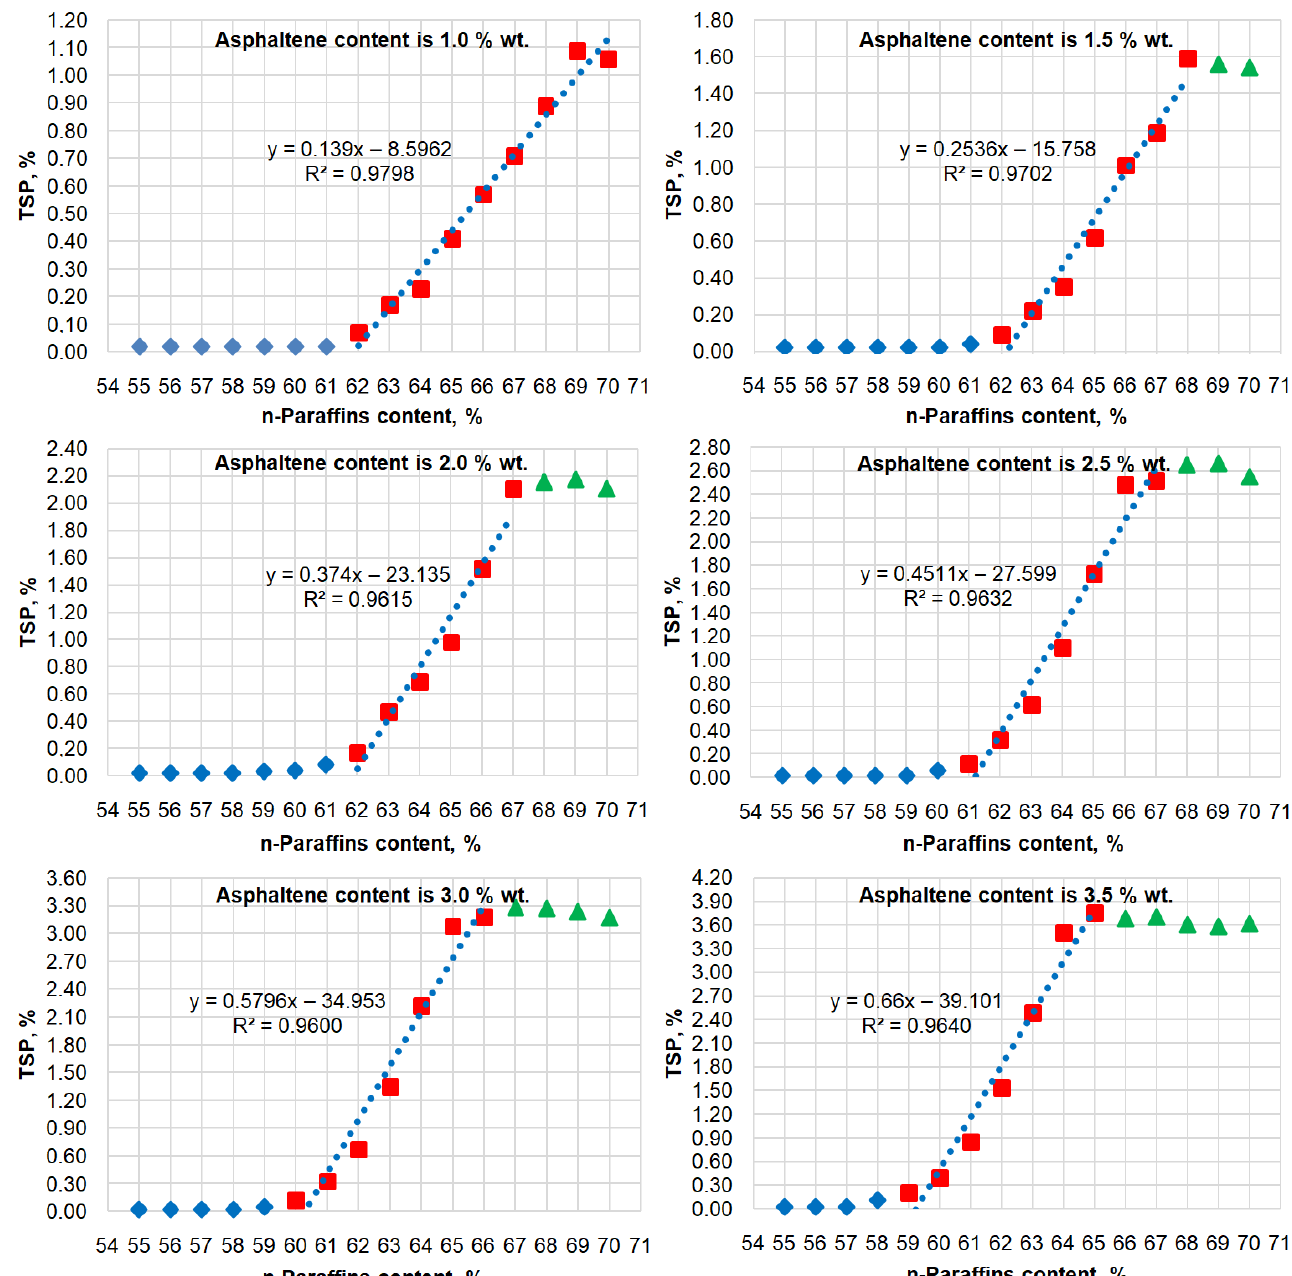
Figure 6. Dependences of the influence of n-paraffins on total sediments at an asphaltene content from 1.0 to 3.5 wt. %. Blue diamonds—no reaction, Red squares—coagulation process, Green triangles—saturation of the coagulation reaction